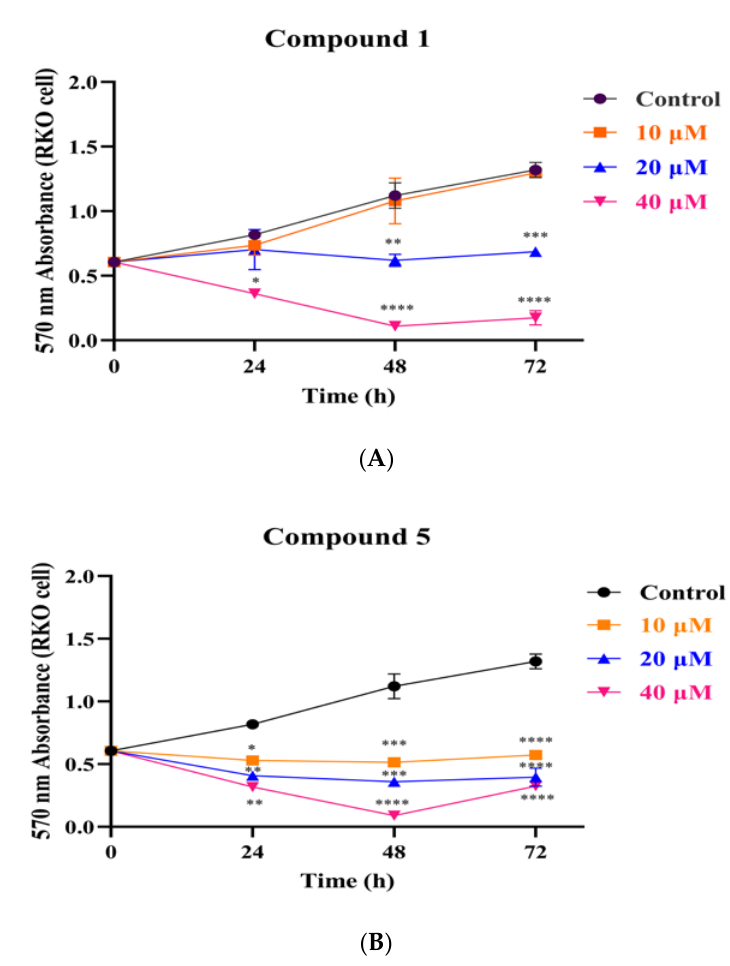
Figure 4. The growth curves of compounds 1 ( A ) and 5 ( B ) after treatment of RKO cells with 10, 20 and 40 μM for 0, 24, 48, and 72 h. * p < 0.05, ** p < 0.01, *** p < 0.001, **** p < 0.0001, in comparison with the corresponding standard groups.